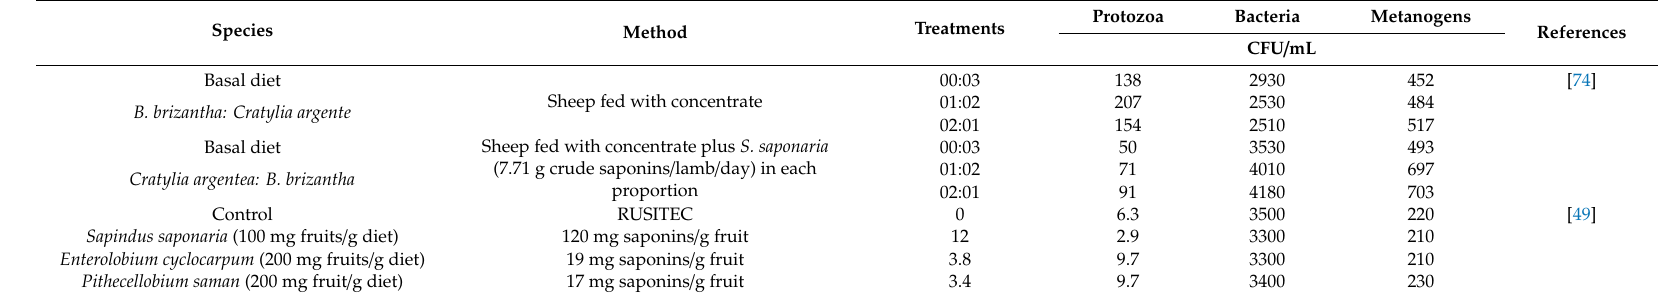
Table 6. E ff ect of metabolites of foliage of tropical trees on the rumen microbial population and CH 4 reduction. Species